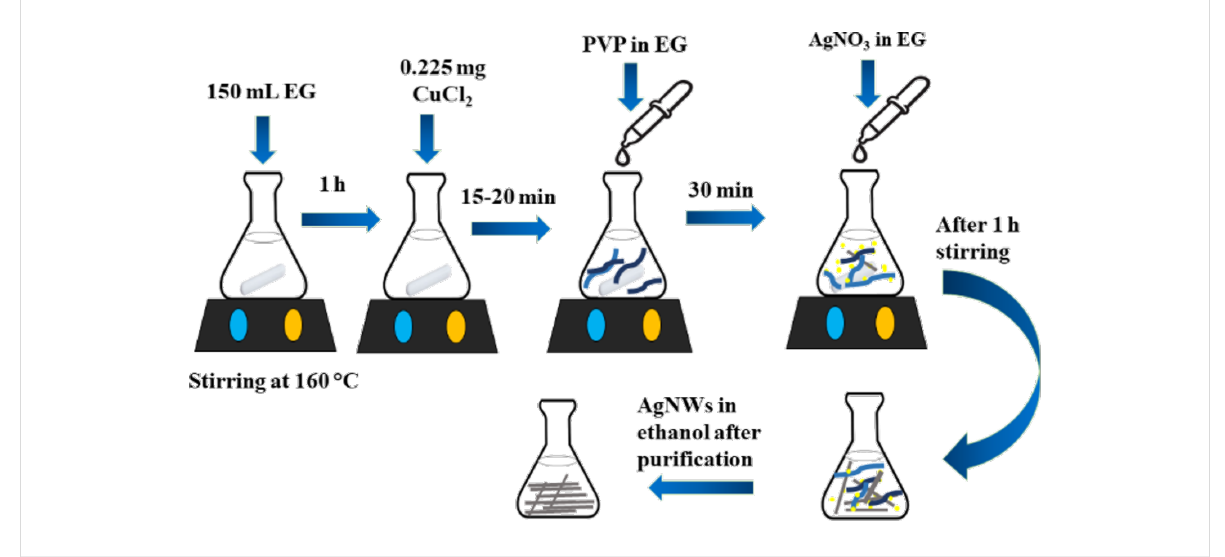
Figure 1: Schematic representation of the modified polyol synthesis of silver nanowires (AgNWs).